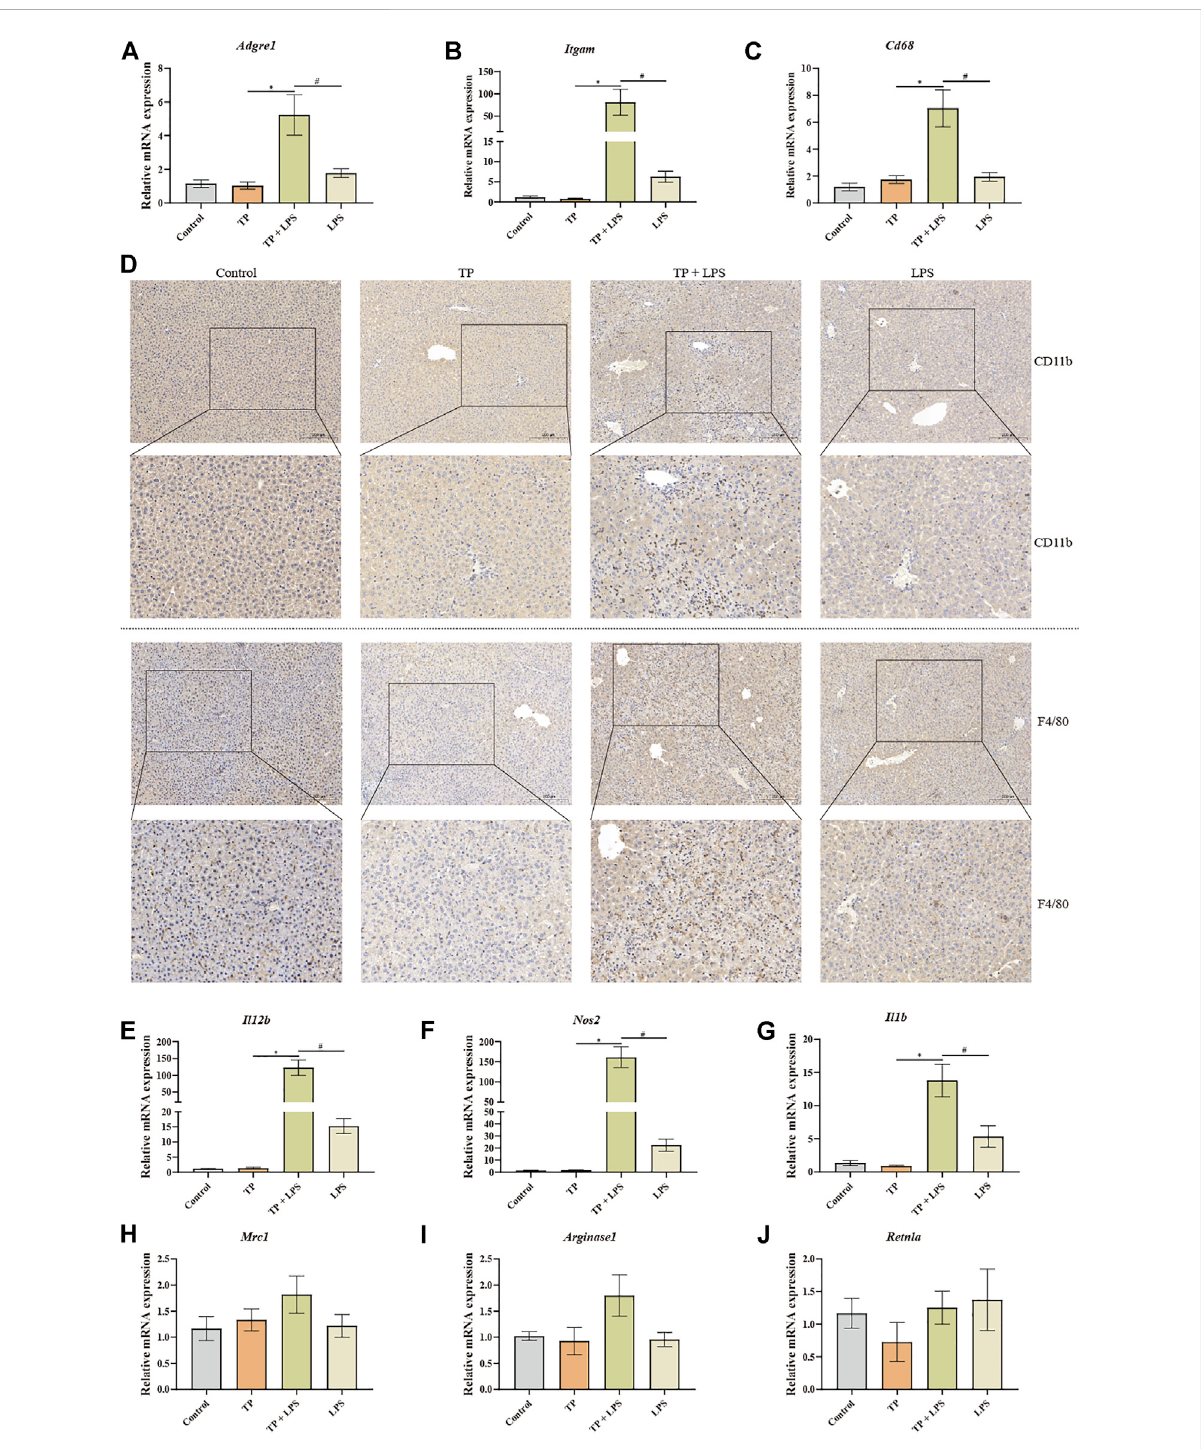
FIGURE 2 TP-induced indirect hepatotoxicity accompanied by macrophage recruitment and fostered the polarization of macrophages to M1 type. (A – C) TherelativemRNAlevelsofhepaticmacrophagemarkers Adgre1 , Itgam ,and Cd68 weredetectedbyqPCRwith Gapdh astheinternalcontrol( n =8). (D) Pictures of liver tissue sections analyzed by IHC for CD11b (top panels) and F4/80 (bottom panels) (×200). (E – J) The relative mRNA levels of M1 macrophage markers ( IL12b , Nos2 , and Il1b ) and M2 macrophage markers ( Mrc1 , Arginase1 , and Retnla ) after TP/LPS treatment, with Gapdh astheinternalcontrol( n =8).Resultswereexpressedasmeans±SEM.StatisticalanalysiswasperformedusingOne-wayANOVAfollowedbyTukey ’ s Multiple Comparison Test. p < 0.05 was considered to be statistically